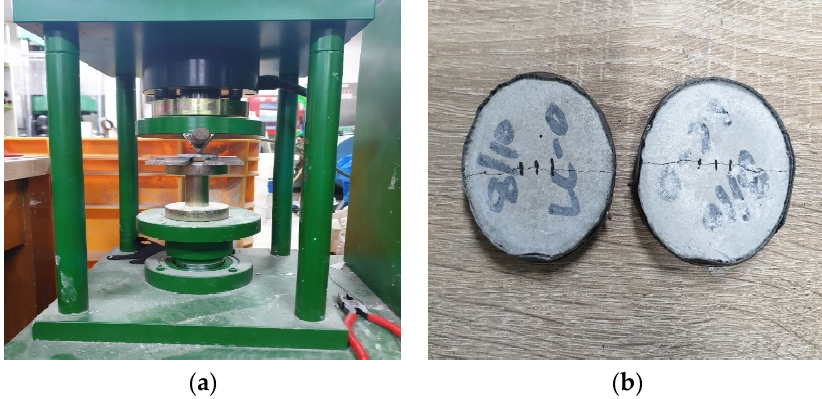
Figure 8. Water flow test specimens.